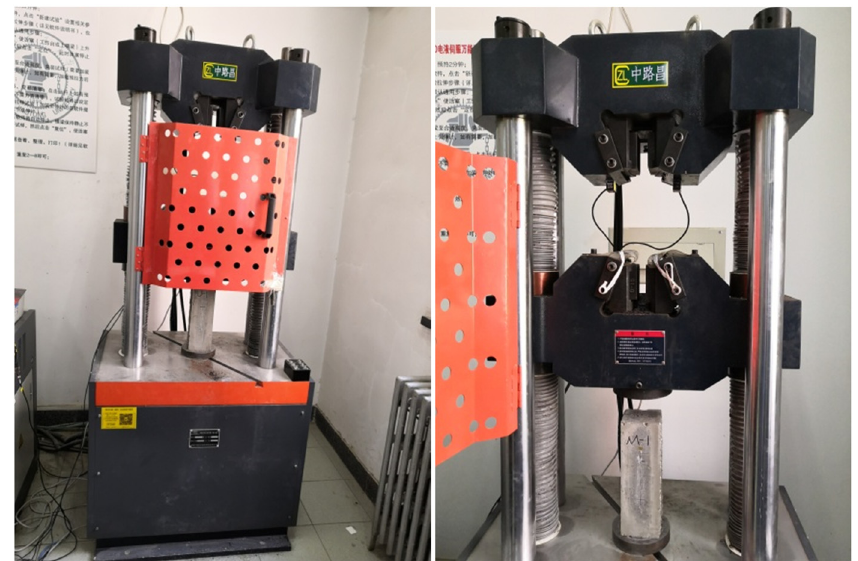
Figure 4: WAW - 600D universal testing machine.